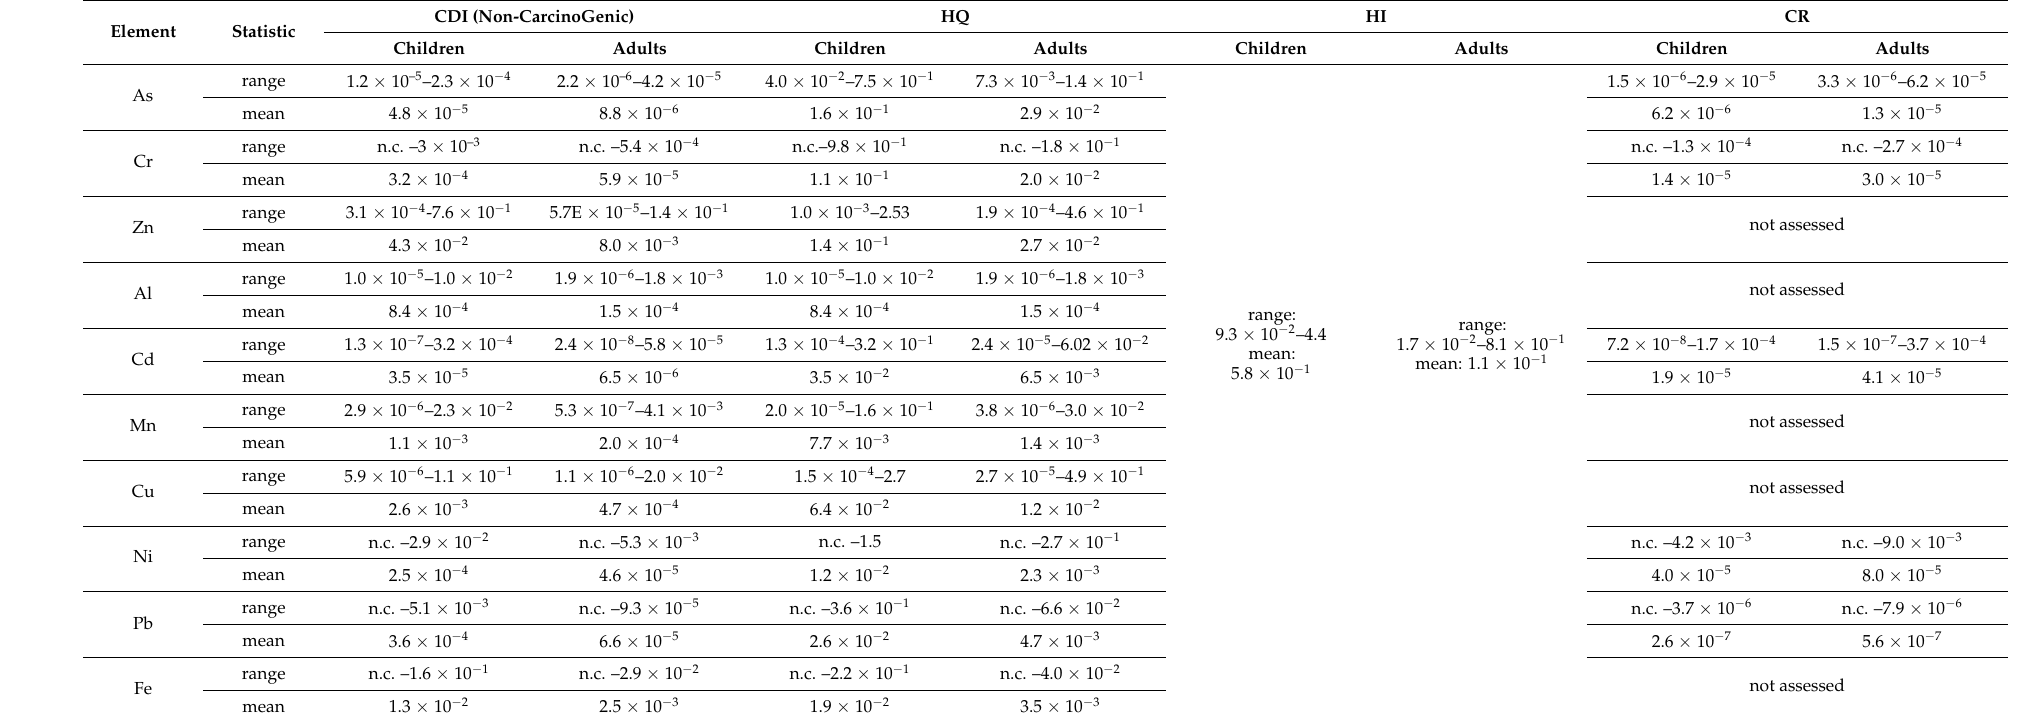
Table 6. Basic statistics for calculated